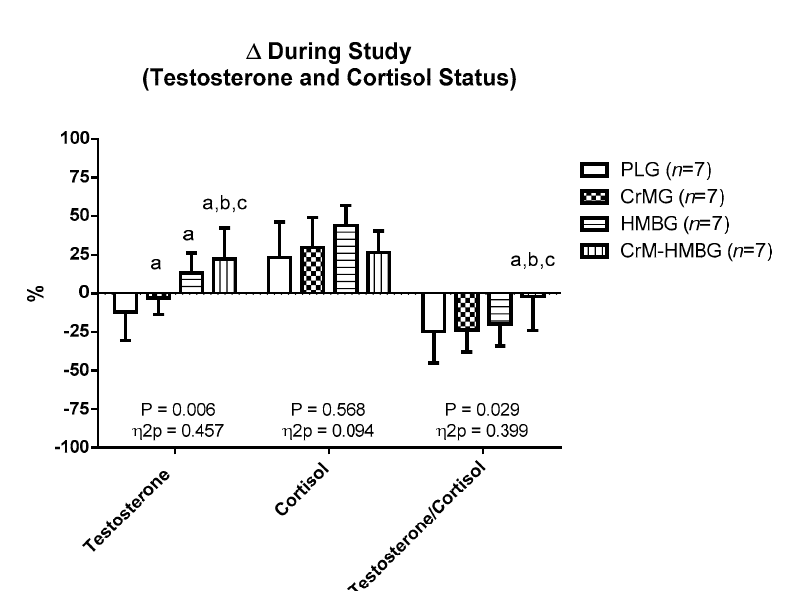
Figure 1. Percentage changes during the study in cortisol and testosterone hormone status and